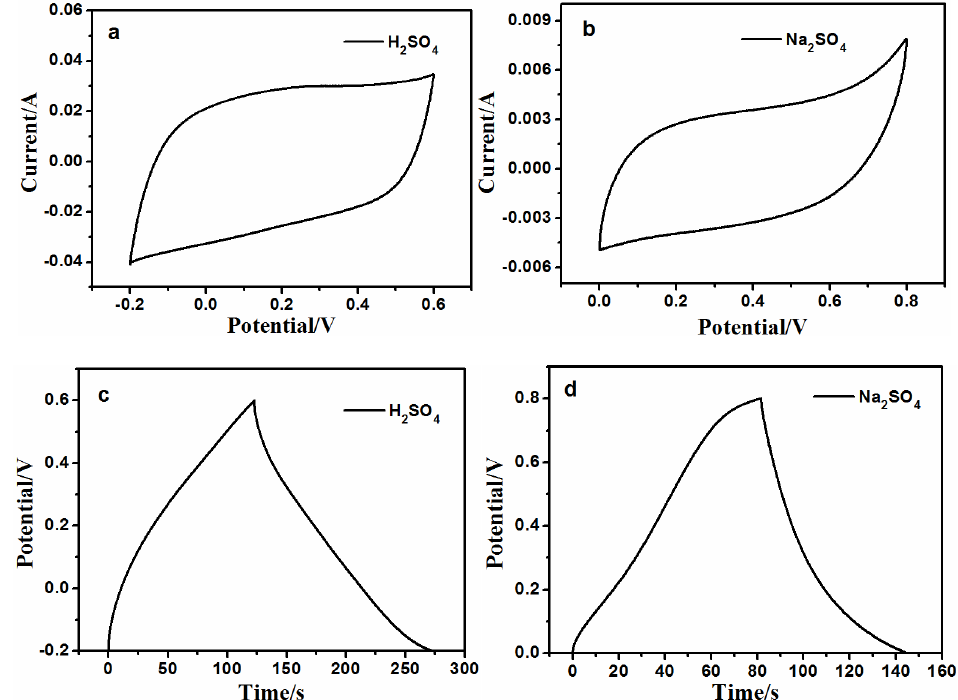
Figure 4. ( a ) Cyclic voltammetry (CV) curves of 50-CDs/rGO (5:1) in 1 M H 2 SO 4 at a scan rate of 0.2 V/s; ( b ) CV curves of 50-CD/rGO (5:1) in 1 M Na 2 SO 4 at a scan rate of 0.2 V/s; ( c ) Galvanostatic charge-discharge (GCD) curves of 50-CDs/rGO (5:1) in 1 M H 2 SO 4 at current density of 1 A/g; ( d ) GCD curves of 50-CDs/rGO (5:1) in 1 M Na 2 SO 4 at current density of 1 A/g.